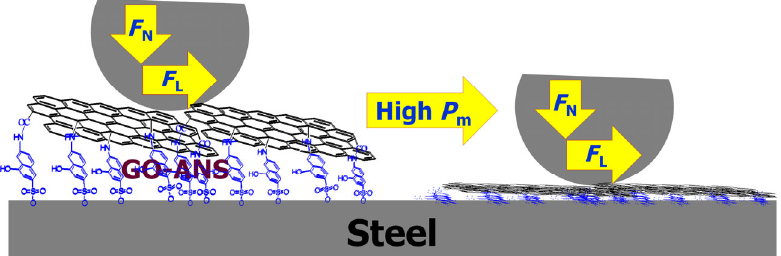
Fig. 13 A schematic showing a possible mechanism how GO-ANS particles can have better adherence to the contact and provide a low friction